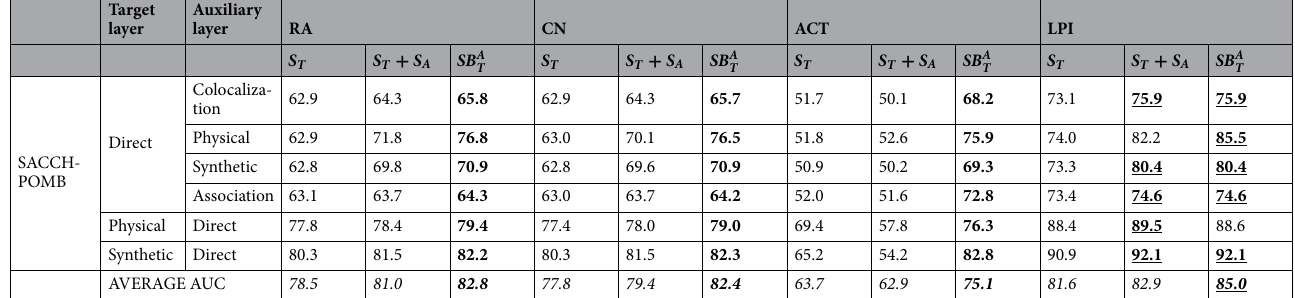
Table 2. Average AUC over 100 iterations for the networks under study. Each row shows the performance of link prediction methods on a duplex subset of a multiplex network grouped by the corresponding base similarity measure in use. Columns show the average AUC over 100 iterations for the prediction methods S T (similarity score of only the target layer), S T + S A (addition of similarity scores of the target and auxiliary A T , A layer), SB T ≡ SB